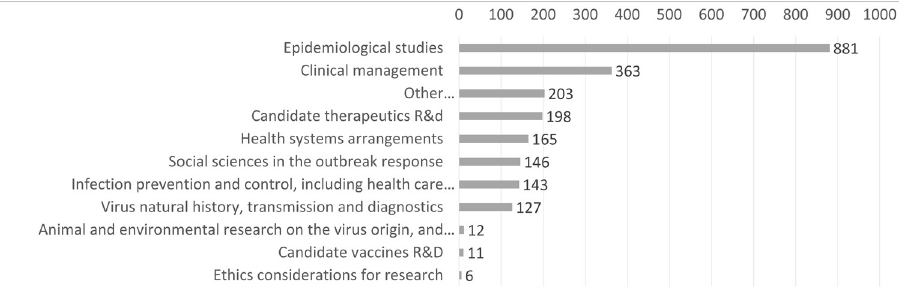
Fig 3. Number of publications per thematic areas of empirical research related to COVID-19 in LAC countries, using the WHO COVID-19 research roadmap.